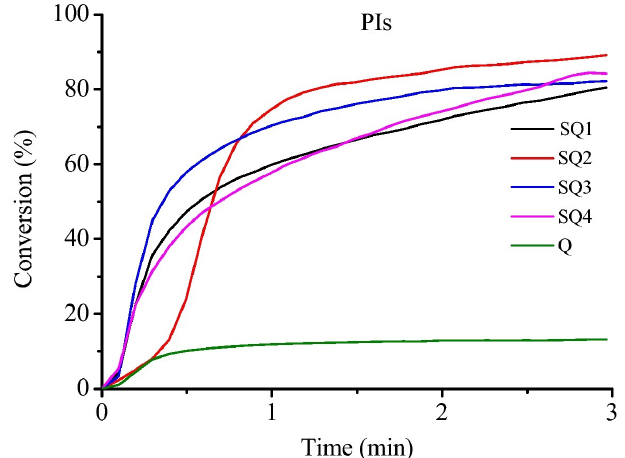
Figure 33. Photopolymerization profiles of HDDA using SQ1–SQ4 as Type I photoinitiators under inert atmosphere. Reproduced with permission of Ref. [244].